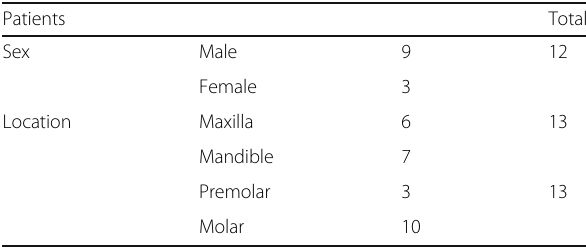
The upper prosthesis consisted of 6 single implant crowns and 7 splinted prostheses. The mesiodistal Table 1 Sex and location of the fractured implant Patients